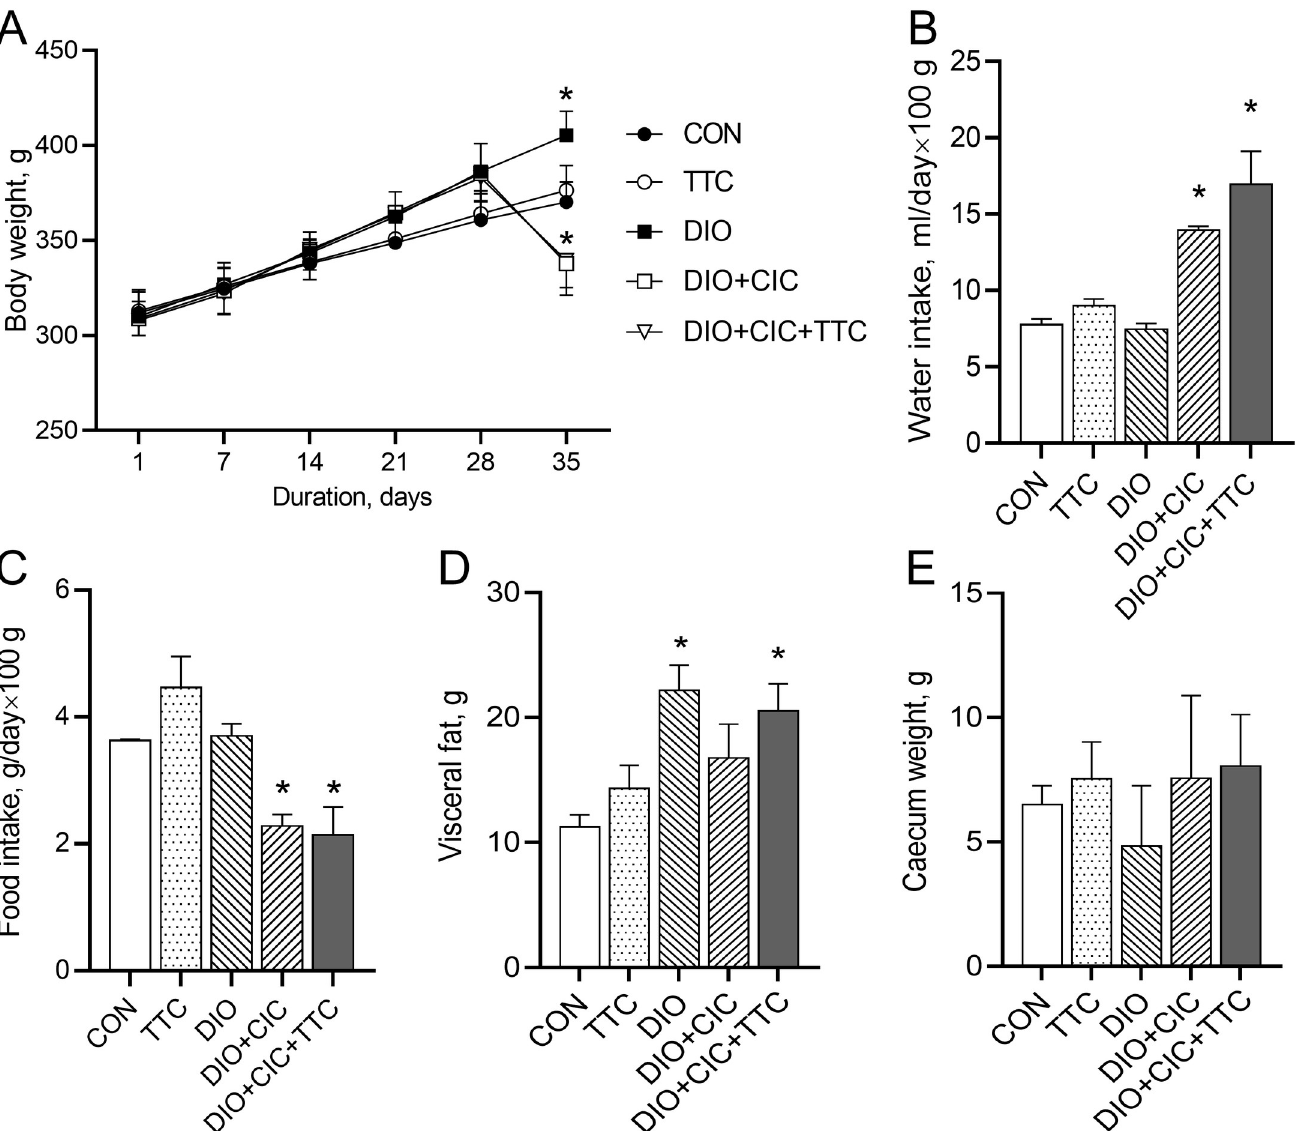
Fig 2. Effects of different treatment regimens on animal body weight, food and water intake, and the weights of visceral fat and the cecum. (A) Weekly changes in body weight, (B) water and (C) food intake, and (D) visceral fat and (E) cecum weights. Data are expressed as mean ± SD. � indicates p < 0.05 when data is compared to that for the CON